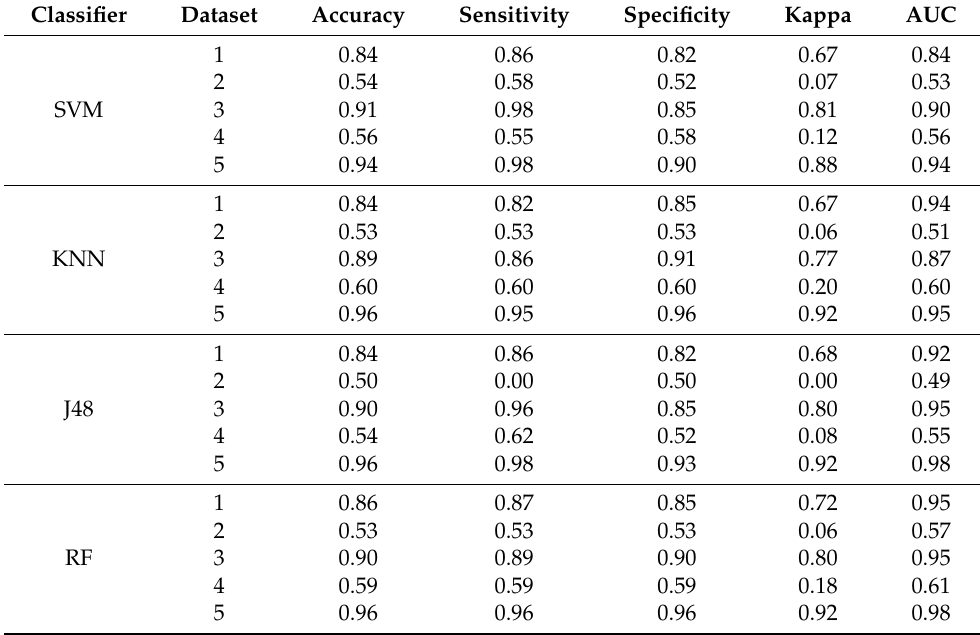
Table 3. Values of different measures for different classification